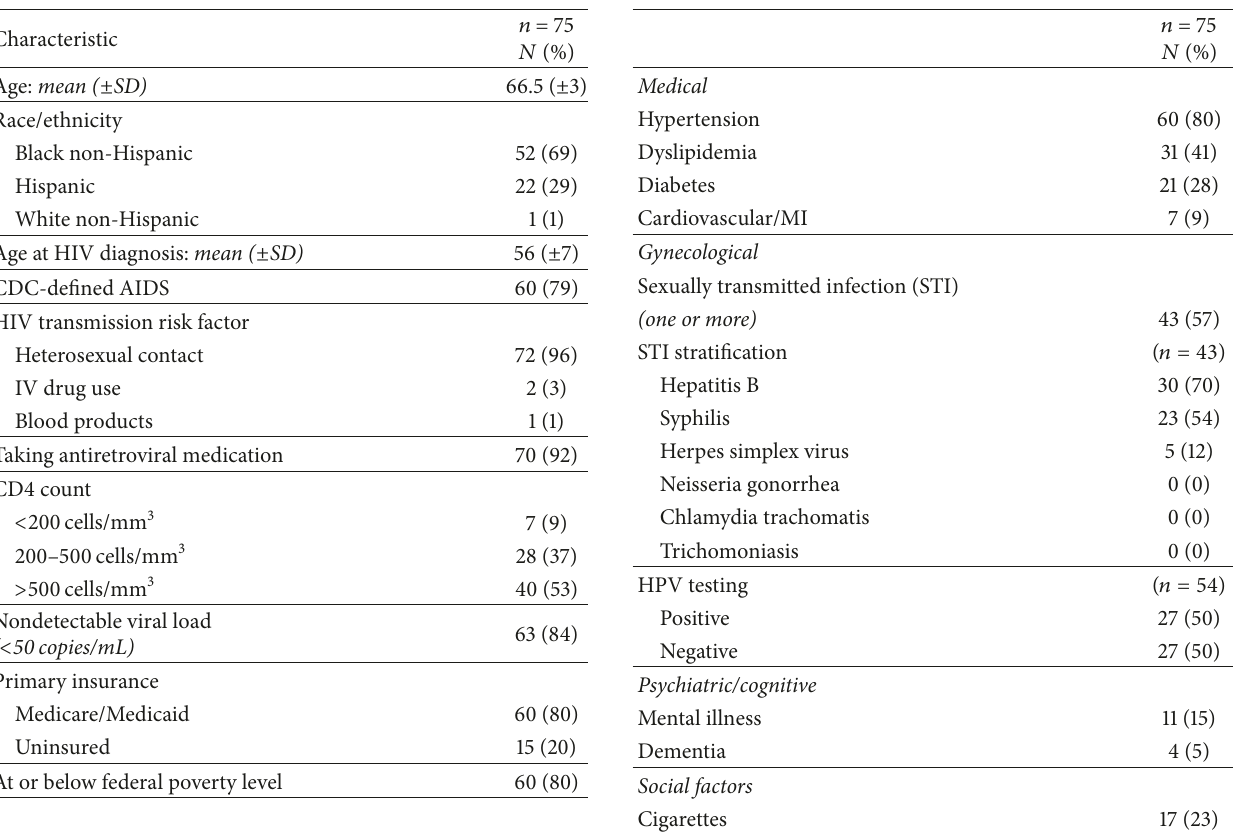
Table 2: Comorbidities and risk factors in HIV+ women > 65 years old.